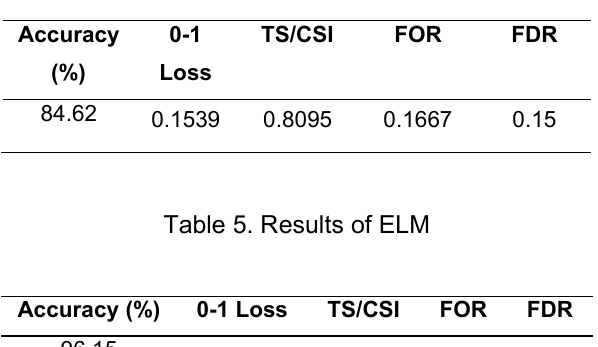
Table 4. Results of ANN